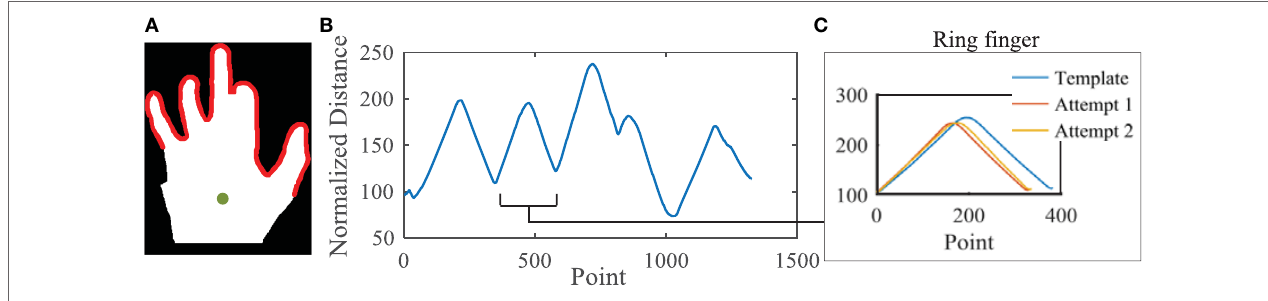
FigUre 2 | image analysis procedure . (a) Preprocessing of the raw image results in a binary figure with the wrist cutoff. The portion being analyzed includes only edges pertaining to digit edges (highlighted in red). The distance between the figure centroid (green) and digit edges is calculated and normalized (B) . (c) Each finger is separated using peaks and valleys. Here, the ring finger has been separated out. The Euclidian errors between template and entry distances are determined for each finger.